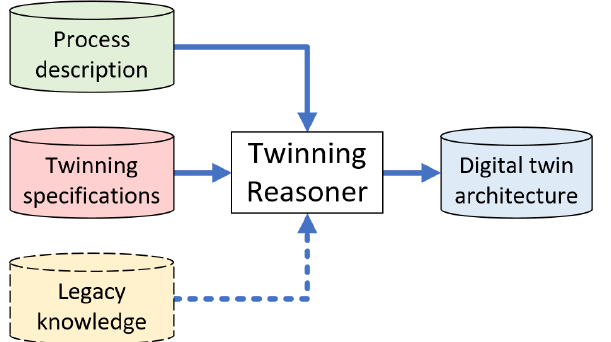
Figure 8. The knowledge-base system for reasoning the digital twin architecture. [Source: Own